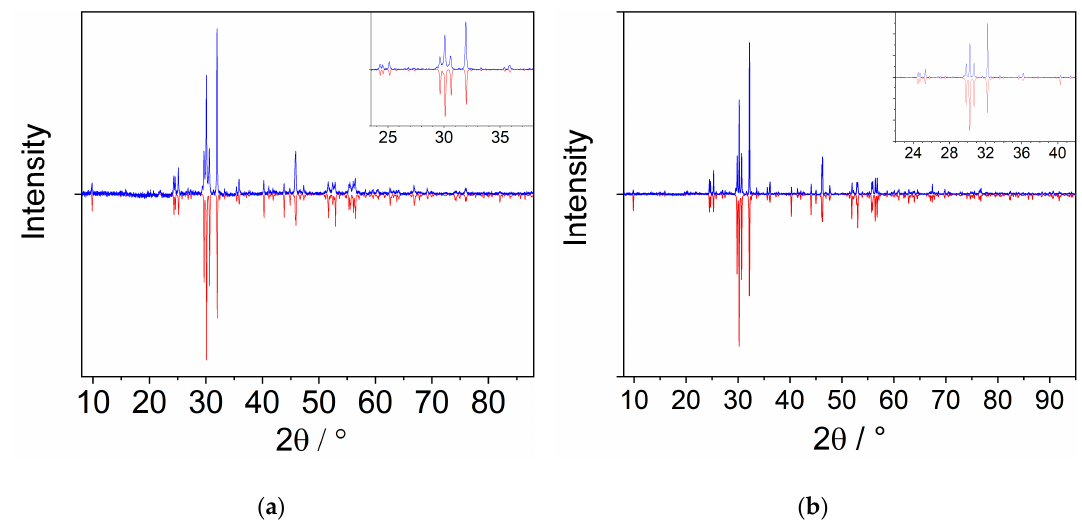
Figure A2. Measured ( blue ) and corresponding simulated ( red ) powder X-ray pattern of EuSb 2 O 4 Br ( a ) and TbSb 2 O 4 Br ( b ). While a high accordance of the measured and calculated reflection positions is given, texture effects probably due to the crystal habit generate visible differences in the relative intensities.